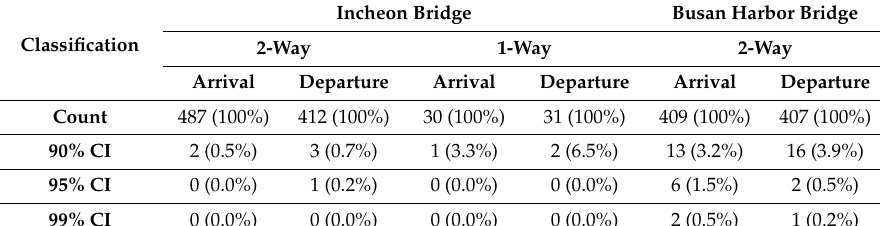
Table 11. Statistics for ships passing outside the confidence interval (90 to 99%).